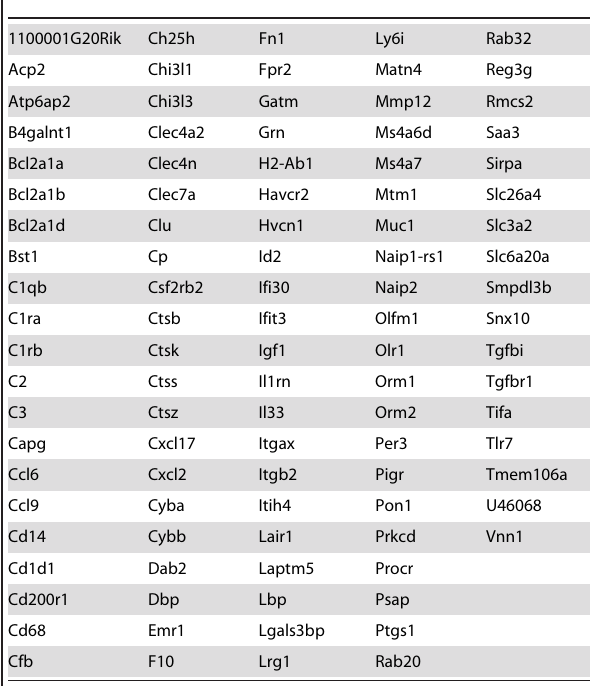
Table 2. Mouse genome identifier (MGI) gene symbols for all genes identified in the 101 gene